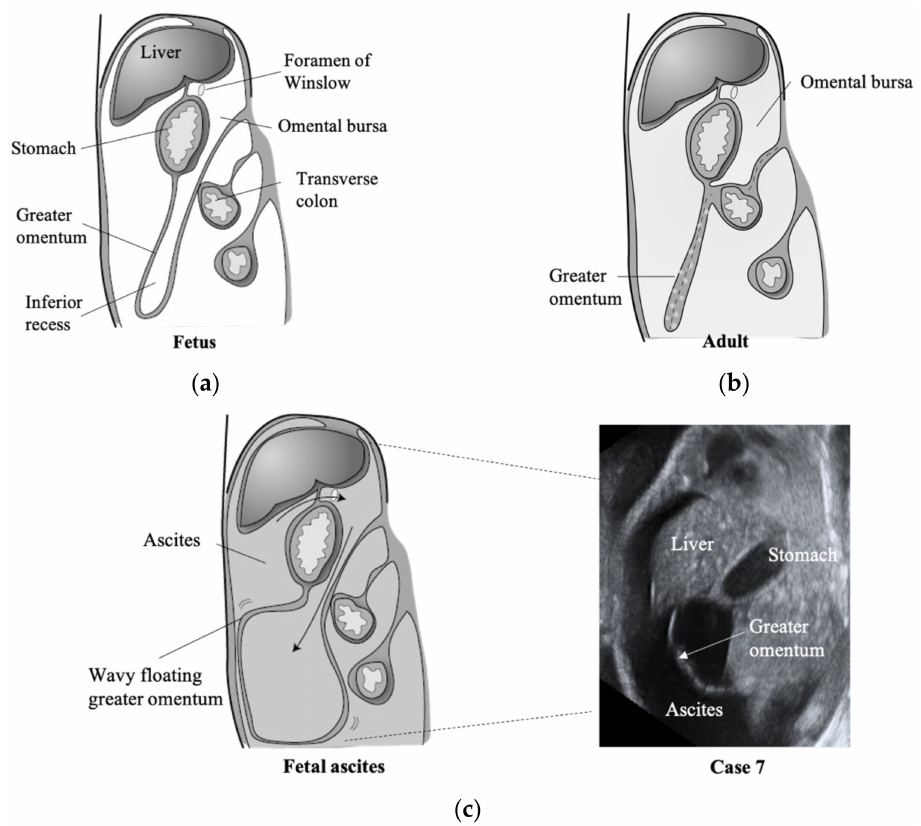
Figure 2. Schematic diagram of the greater omentum in an adult ( a ), fetus ( b ), and fetus with ascites ( c ). The parts where the membrane is fused are shown by dashed lines in ( b ). Arrows in ( c ): ascites enters the omental bursa through the foramen of Winslow into the inferior